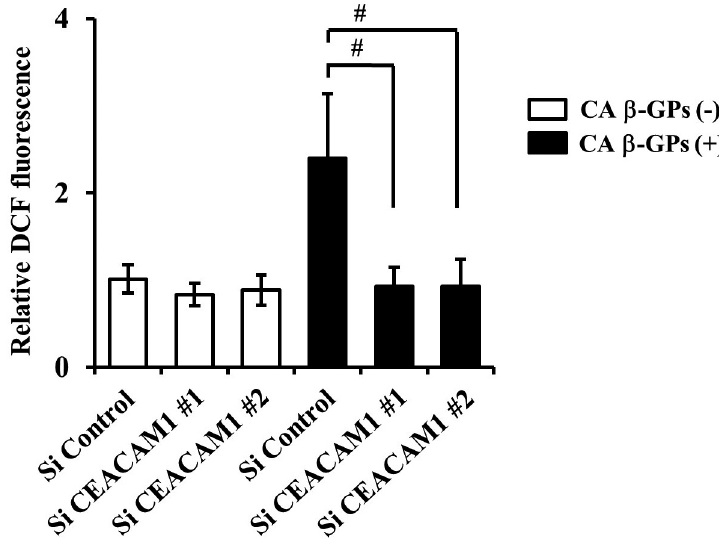
Figure 8- Effects of knockdown of CEACAM1 on β-GPs-induced reactive oxygen species in RT7 cells Cells were transfected with CEACAM1 siRNA for 48 hours, then labelled with DCF-DA for 30 minutes and stimulated with C. albicans β-glucan-containing particles (CA β-GPs) (200 μg/mL) for 1 hour. Fluorescence intensity was then determined. Values are shown as fold increase as compared with the intensity of Si control cells and presented as the mean ± SD of five independent experiments. #Significantly different from Si control-transfected cells stimulated with C. albicans β-GPs alone (Bonferroni/ Dunn's multiple comparison test, p<0.05).